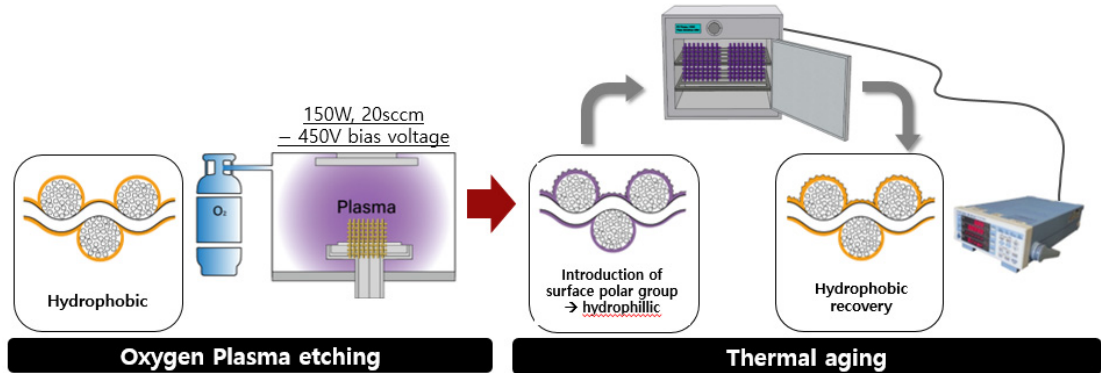
Table 1. Sample codes during the treatments.